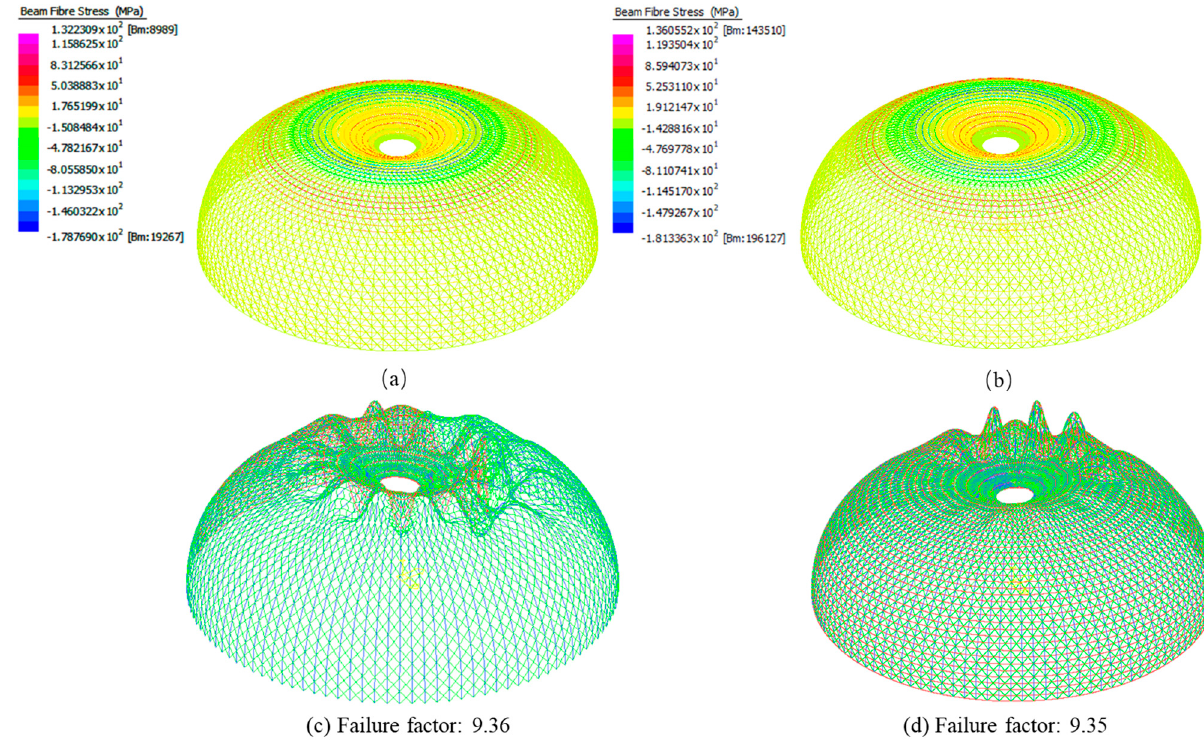
Figure 9. ( a ) Linear analysis of total fiber stress of curved member model under 1.2G + 1.5Q; ( b ) nonlinear analysis of total fiber stress of curved member model under 1.2G + 1.5Q; ( c ) linear buckling analysis of the straight member model under 1.2G + 1.5Q; ( d ) linear buckling analysis of the curved member model under 1.2G + 1.5Q.